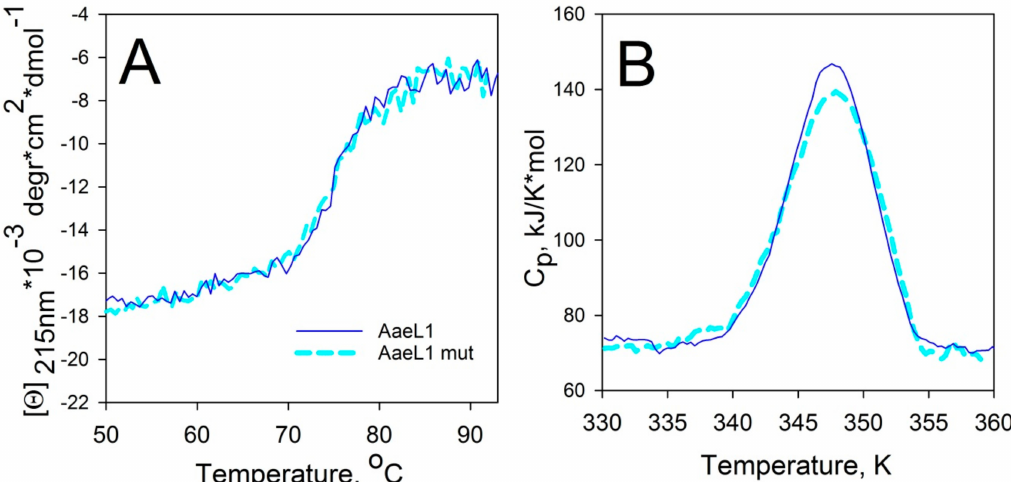
Figure 8. Heat denaturation of AaeL1 proteins (wild type and AaeL1–D101C–K127C). ( A ) Dependence of molar ellipticity at 215 nm on temperature in 4 M urea for wild type AaeL1 (solid line) and for AaeL1–D101C–K127C (dashed line). ( B ) Dependence of partial heat capacity on temperature in 4 M urea for wild type AaeL1 (solid line) and AaeL1–D101C–K127C with oxidized disulfide bond (dashed